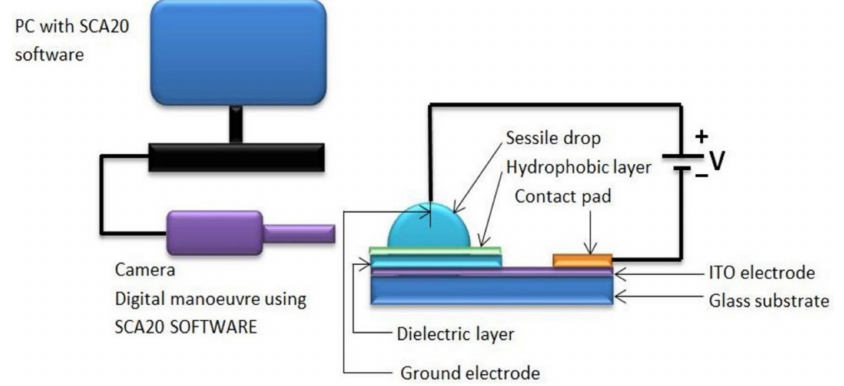
Figure 3. Experimental setup for sessile-drop